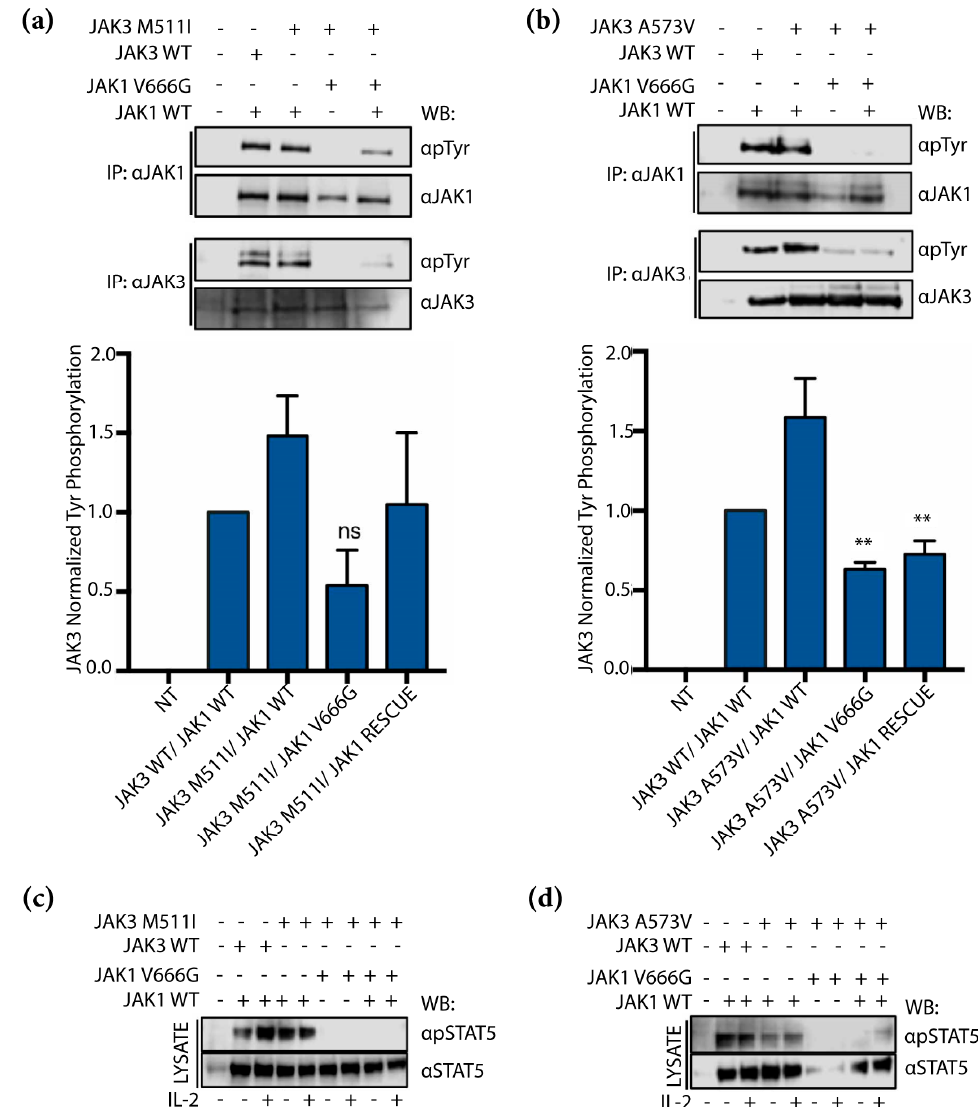
Figure 5. JAK1 V666G inhibits Tyr phosphorylation of JAK3 M511I and A573V activating mutants. Western blot (WB) of protein lysates from U4C cells non-transfected (NT) or transiently transfected with JAK1 MYC constructs, and ( a ) JAK3 M511I or ( b ) A573V. Overexpressed JAK1 and JAK3 were immunoprecipitated (IP) and examined for changes in Tyr phosphorylation across the transfected conditions, including a JAK1 WT rescue. Graphed data represent the means ± SEM of JAK3 M511I- or A573V-normalized Tyr phosphorylation from independent experiments ( n = 3). Statistically significant conditions, ** p < 0.0073, were found using a one-way ANOVA with a post hoc Tukey’s test for multiple comparisons. ns = not statistically significant. ( c , d ) IL-2 receptor constructs and low levels of JAK1 and JAK3 constructs were transfected into U4C cells. Twenty-four hours post-transfection, cells were stimulated with IL-2 for 10 min. Total cell lysate was examined for STAT5